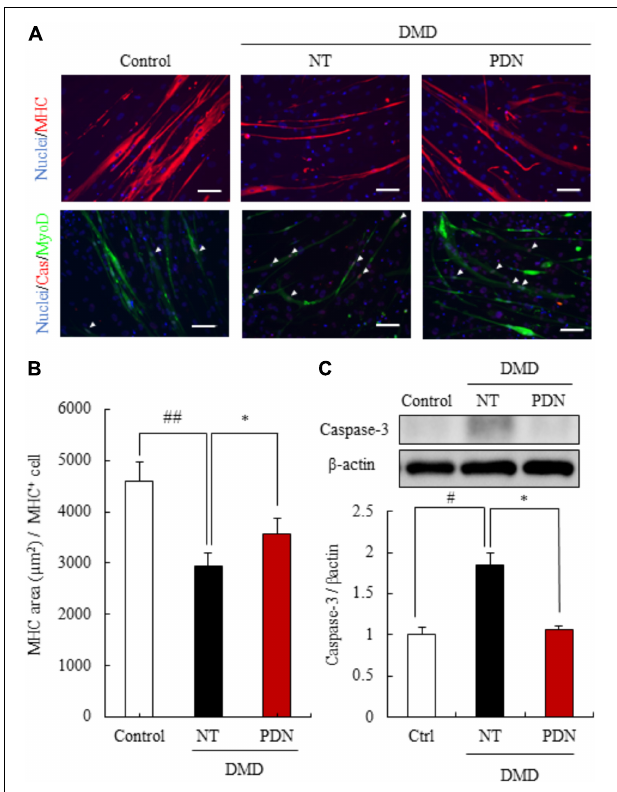
FIGURE 4 | Efficacy of prednisolone in reversing DMD pathology. (A) Immunostaining using skeletal muscle marker (myosin heavy chain, MHC), and apoptosis marker (cleaved caspase-3, Cas). Prednisolone (PDN) restored decreased MHC area and increased apoptosis cells. Scale bars = 100 µ m. (B) Quantification of the MHC area of myotubes from control individual, non-treated myotubes from DMD (NT), and prednisolone-treated myotubes from DMD (PDN). Data are shown as means ± SEM ( n = 4). (C) Western blot analysis of cleaved caspase-3 in control individual (Ctrl), NT, and PDN. Data are shown as means ± SEM ( n = 5). # p < 0.05 vs. Ctrl and ∗ p < 0.05 vs. NT (Student’s t -test), ∗ p < 0.05 vs. NT (Student’s t